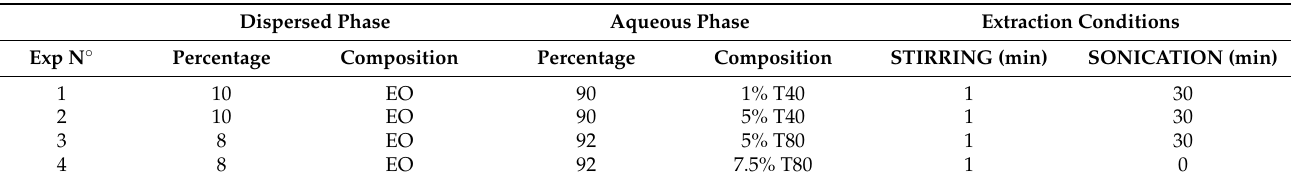
Table 1. Parameters of nanoemulsion formulation. Dispersed and aqueous phases percentages and compositions. EO: essential oil; emulsifier (T40: Tween 40; T80: Tween 80) and ultra-agitation and sonication conditions (min: